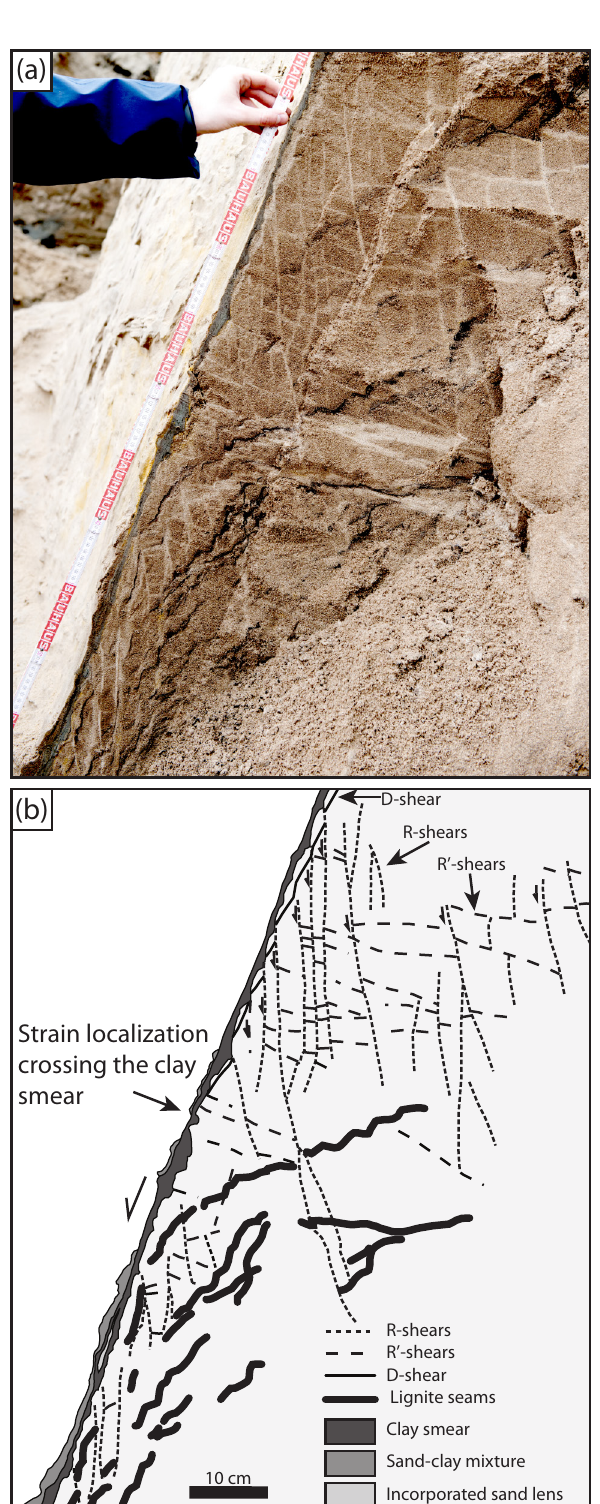
Figure 13. R shears in the footwall deform the clay smear in a stair-stepping pattern. Clay smear is thinnest in elongation of the R shears. Intense grain-scale mixing at the hanging-wall side occurs in the lower half of the section, coinciding with a D shear crossing the clay smear approximately at the position marked by an